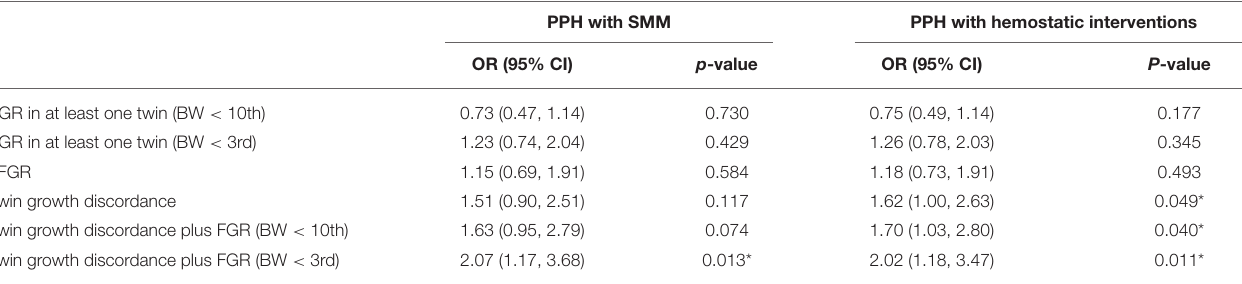
TABLE 3 | The Associations between twin growth discordance, fetal growth restriction (FGR), and secondary outcomes. PPH with SMM PPH with hemostatic interventions